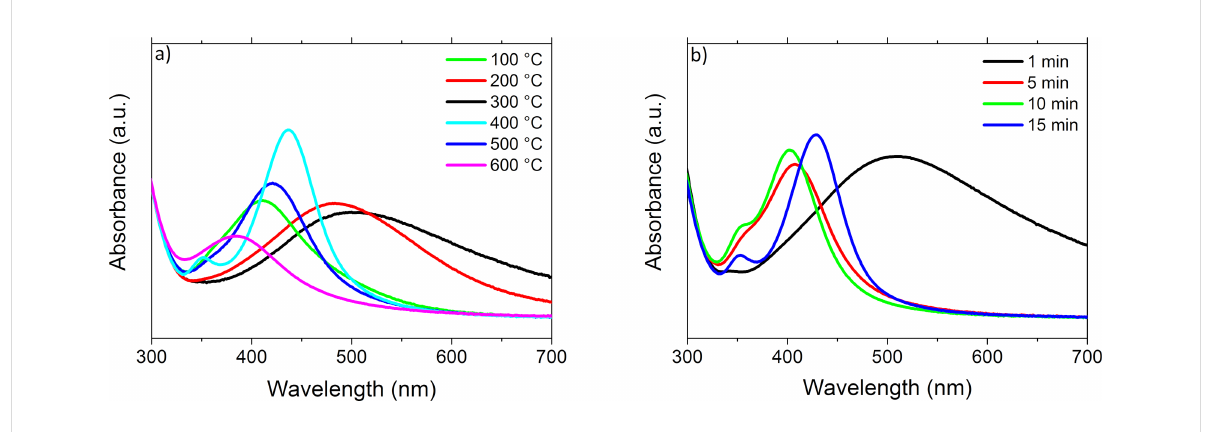
Figure 11: Absorbance of nanostructures formed from 2.8 nm thick films (a) annealed at 100, 200, 300, 400, 500 and 600 °C for 15 min and (b) annealed for 1, 5, 10 and 15 min at 550 °C.